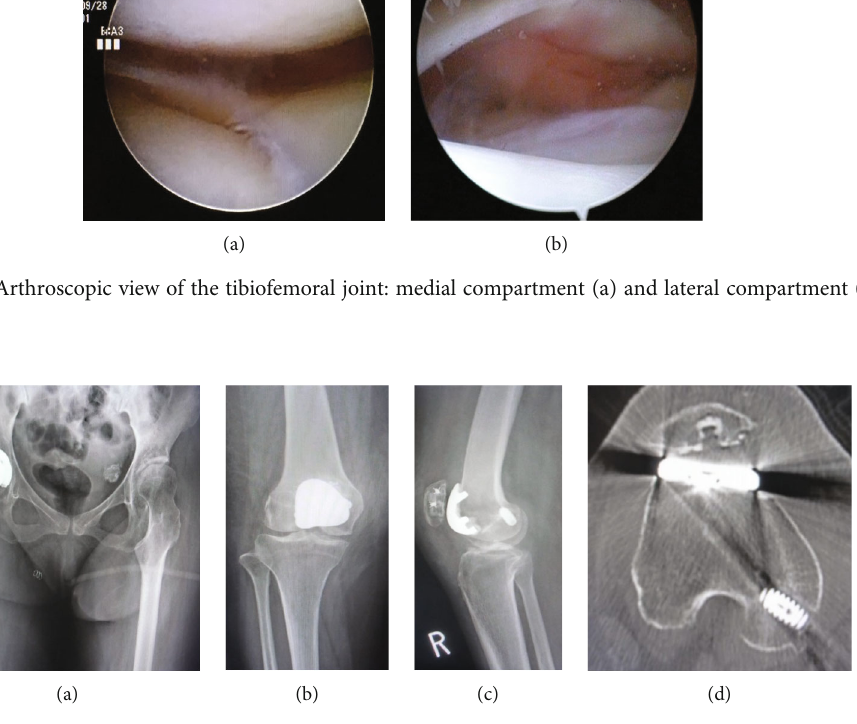
Figure 3: (a) X-ray of the hip after the fi rst-stage surgery. (b) Postoperative X-ray of the right knee; anteroposterior view. (c) Postoperative X-ray of the right knee; lateral view. (d) Postoperative computed tomography of the right